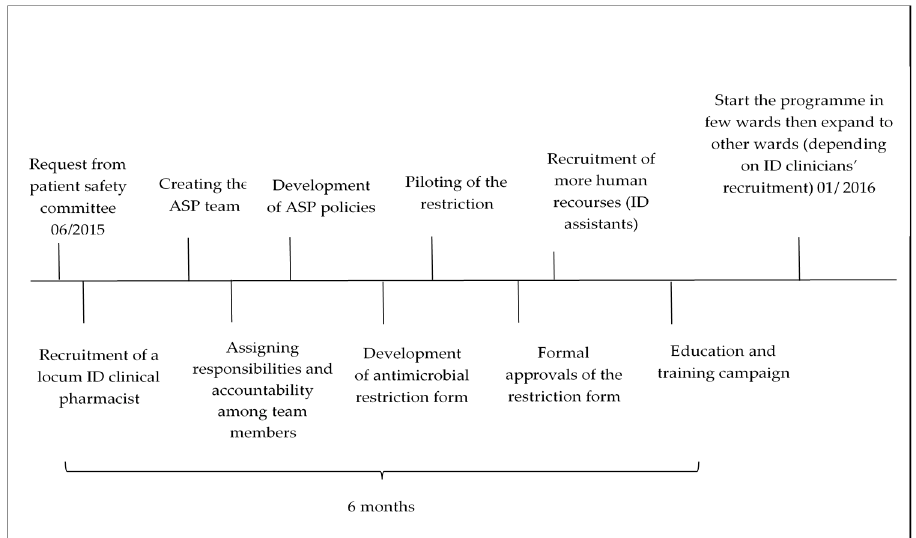
Figure 3. The timeline for implementing the ASP in the medical city.